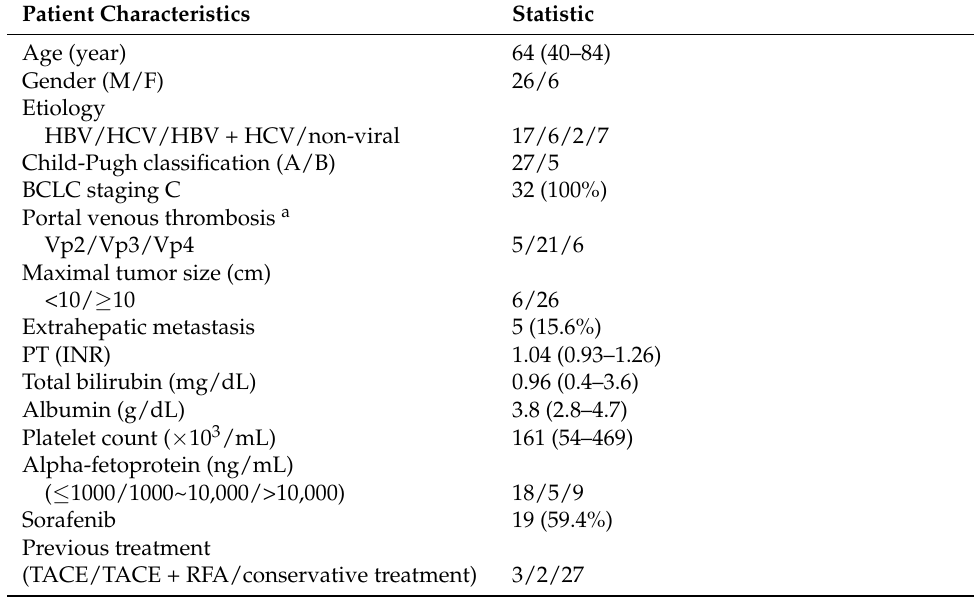
Table 1. Baseline clinical